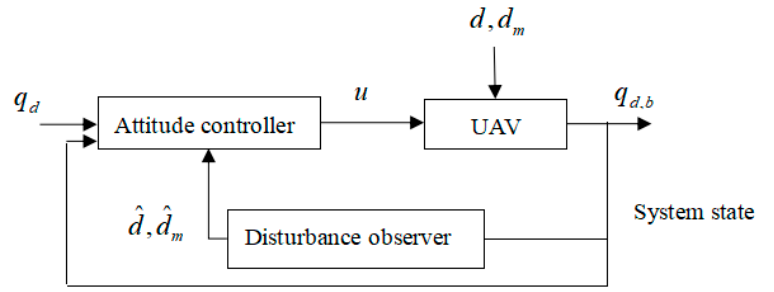
Figure 1. Attitude control diagram of the quadrotor UAV.